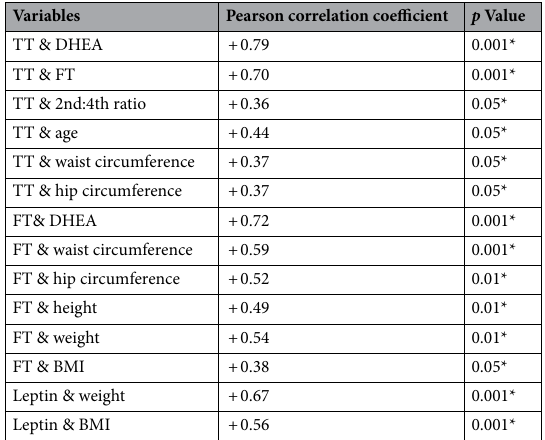
Table 3. Correlation between different variables in the autism group. * p ≤ 0.05 is considered statistically significant.